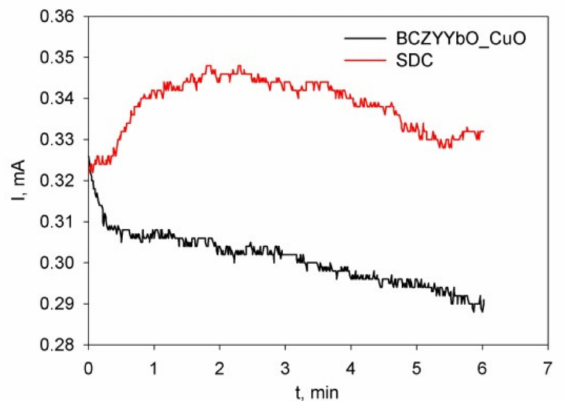
Figure 6. Dependence of the current strength on time for EPD from a suspension of BCZYYbO-CuO (15 g/L) (cell voltage 80 V) and 10 g/L SDC (cell voltage 60